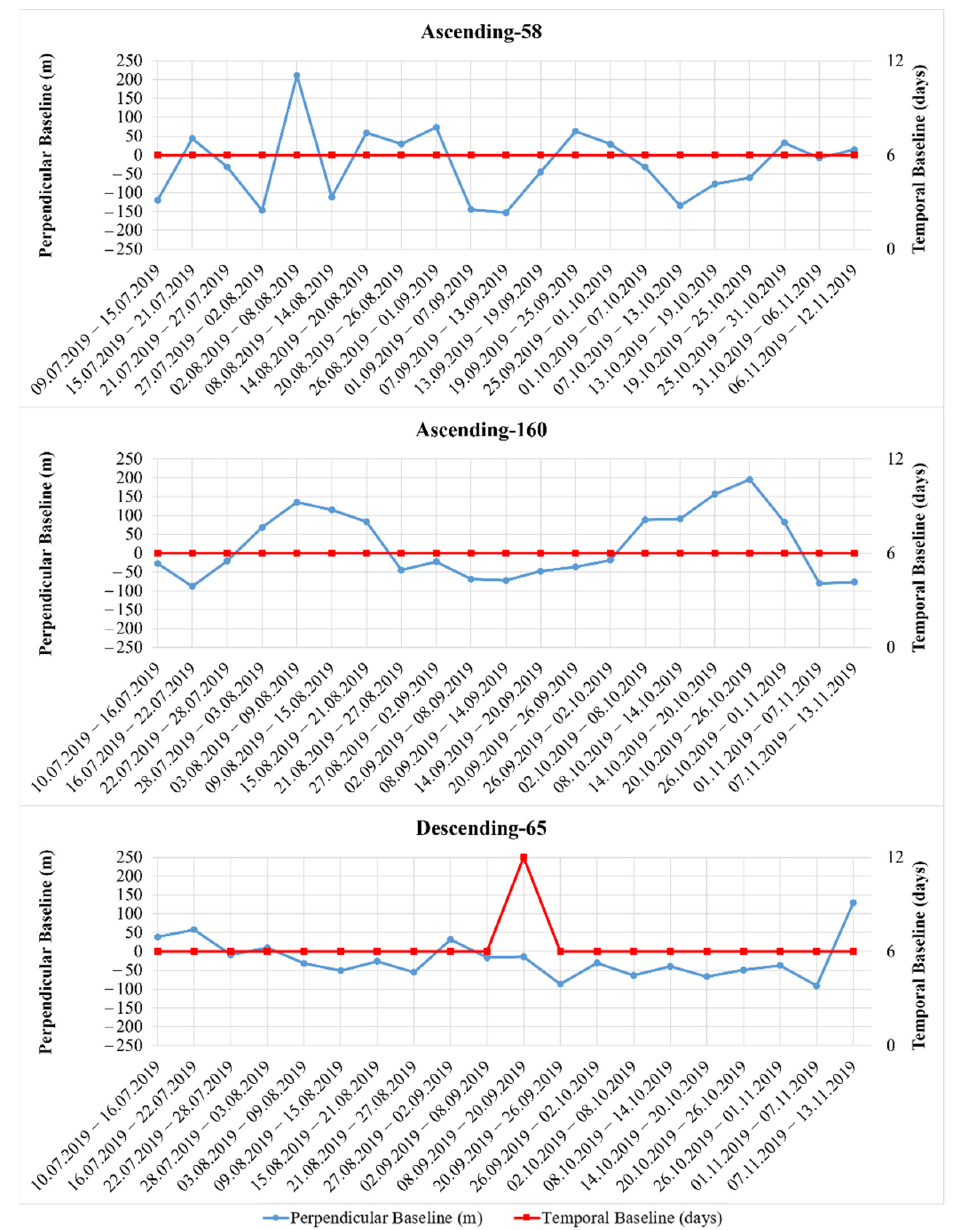
Figure 6. Interferometric properties of Sentinel-1 satellite image pairs used in the study.